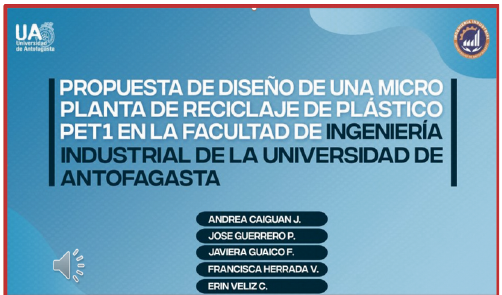
Figure 20. Final Projects